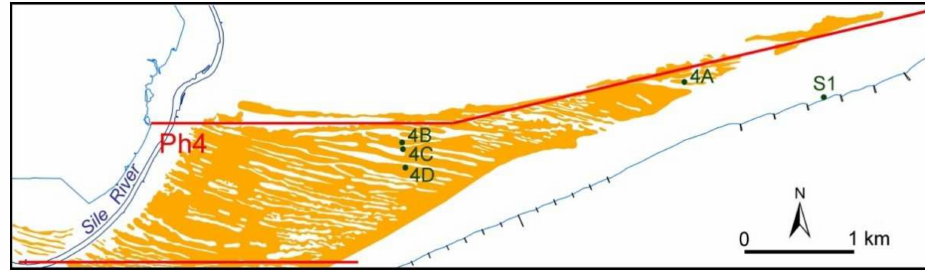
Figure 5. Arrangement of the ancient sandy ridges that define the fourth progradation phase (Ph4) (rectangle D in Figure 1). The green dots indicate core locations. S1 is a sample collected close to the